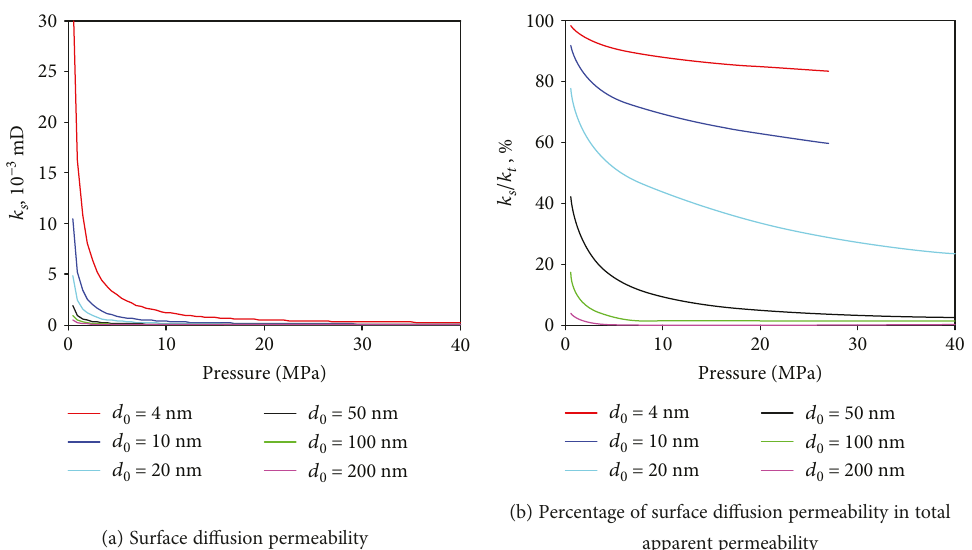
Figure 9: Surface di ff usion permeability and its percentage in total apparent